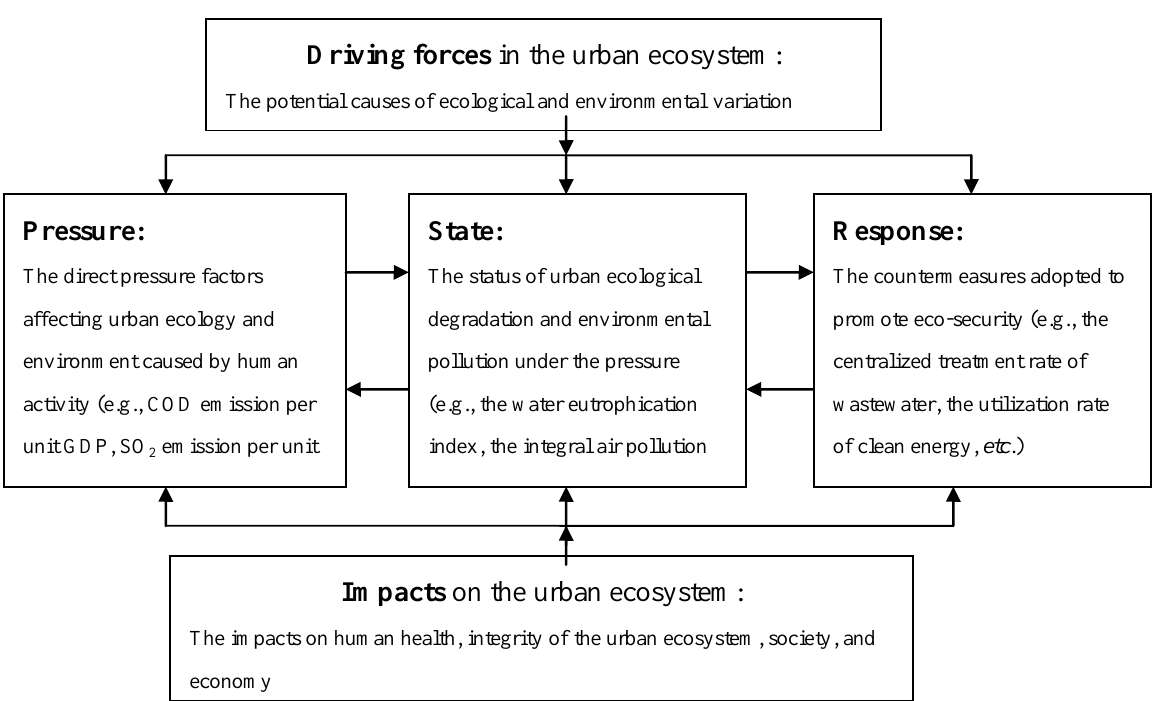
Figure 3. The DPSIR framework for the urban eco-security